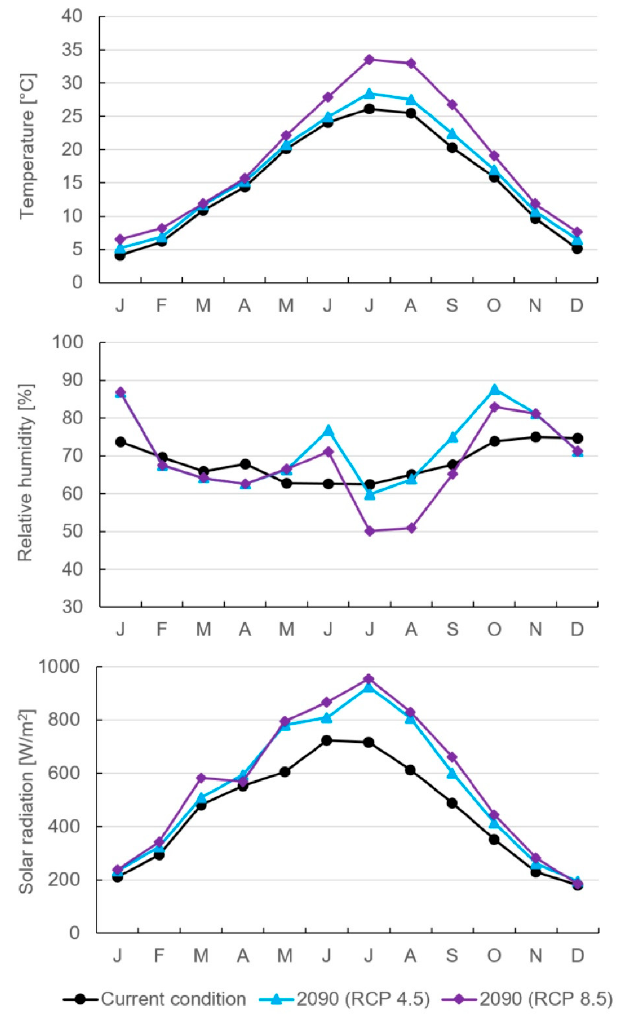
Figure 9. Mean monthly temperature, relative humidity, and solar radiation for the different cli- mate